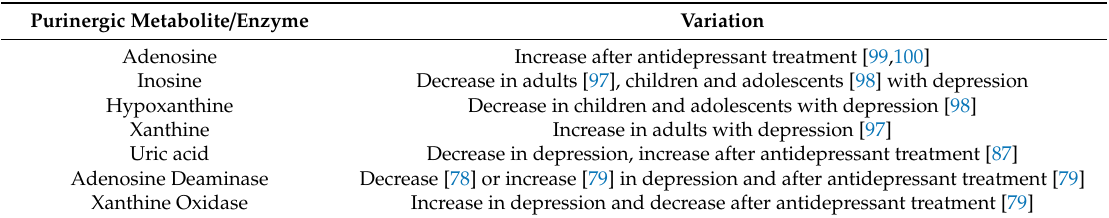
Table 1. Variations of serum / plasma purinergic metabolites and enzymatic activity in